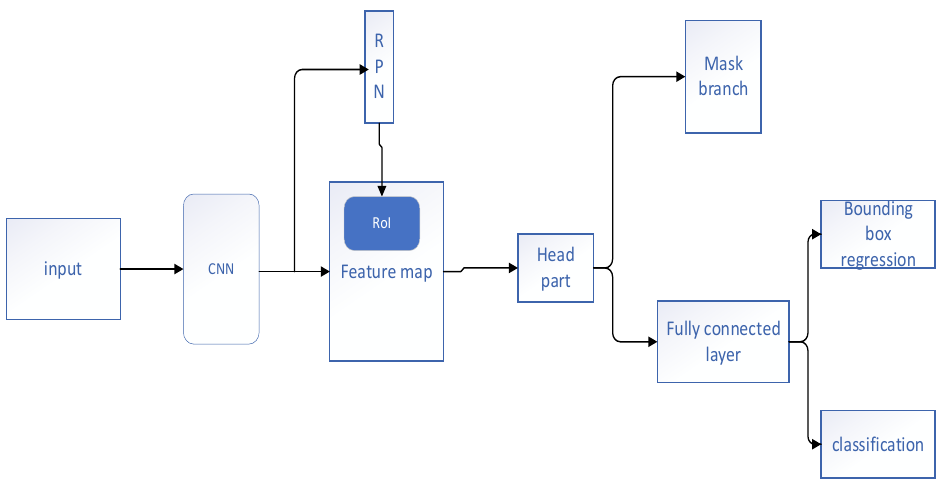
Figure 3. Architecture of the method proposed by Cao et al. [5]. Zhang et al. [8] considered that the models trained from CNNs contained millions of parameters, most of which were likely to cause overfitting in training. To avoid overfitting and achieve quick convergence, they used a concise model called the gastric precancerous disease network (GPD Net) to achieve the classification of three categories of GPD, which were polyp, erosion, and ulcer, respectively. This network introduced fire modules to take the place of traditional convolutional layers. The fire modules were made up of a squeezed convolutional layer (which had only 1 × 1 filters) feeding into an expanded layer (which had both 1 × 1 filters and 3 × 3 filters). The fully connected layers were taken out to realize the FCN. The size and parameters of the model were reduced by approximately 10 times, improving the speed of rapid classification. Moreover, they put forward an innovative fine-tuning method called iterative reinforced learning (IRL) in order to maintain the clas- sification accuracy when training the network with fewer parameters. The experimental